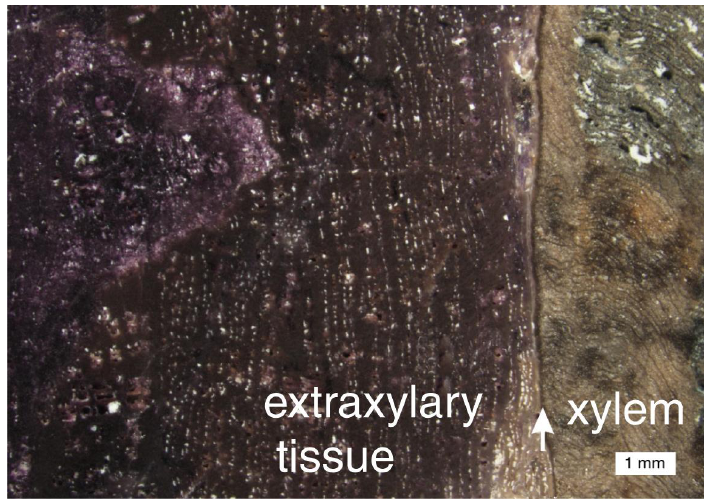
Figure 27. In many specimens of Chemitz wood that contain fluorite, the mineral occurs in irregular patchy zones, but in this sample, the main trunk tissue (xylem) is silicified, and fluorite is restricted to the outermost stem tissues (extraxylary tissues). Arrow marks cambium layer. Photo courtesy of Ronny Röβler, used with permission.